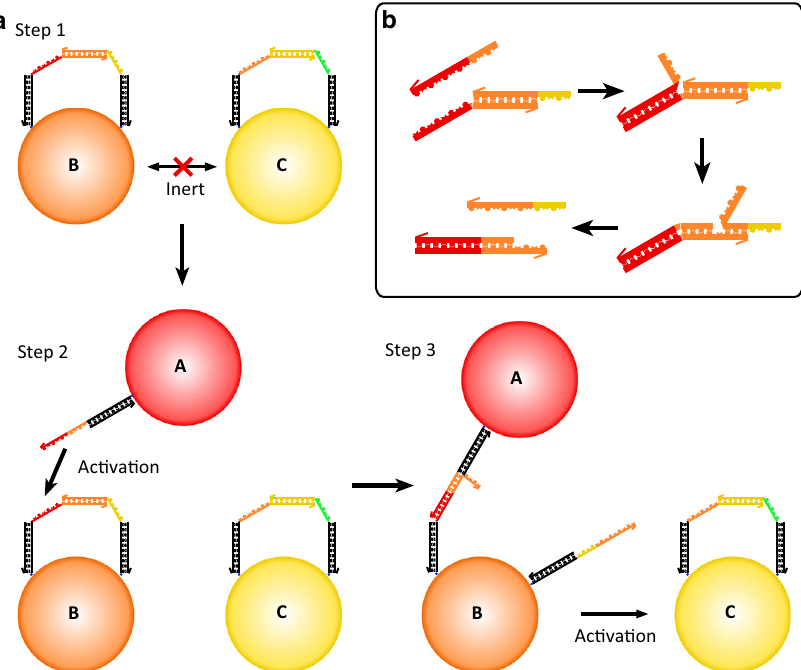
Fig. 1 A schematic of sequential self-assembly. a Step 1: two droplets, B and C, with partially hybridized pairs of DNA strands are inert. Step 2: a droplet with an initiator strand, A, is introduced. Step 3: the initiator strand fully hybridizes to the protection strand on B through toehold strand displacement and frees the protected strand, leading to the activation of droplet B. The freed strand on B can then hybridize with the protection strand on C making a B – C bond and activating C for further binding. b Schematic of the toehold displacement reaction showing details corresponding to the activation process of ( a